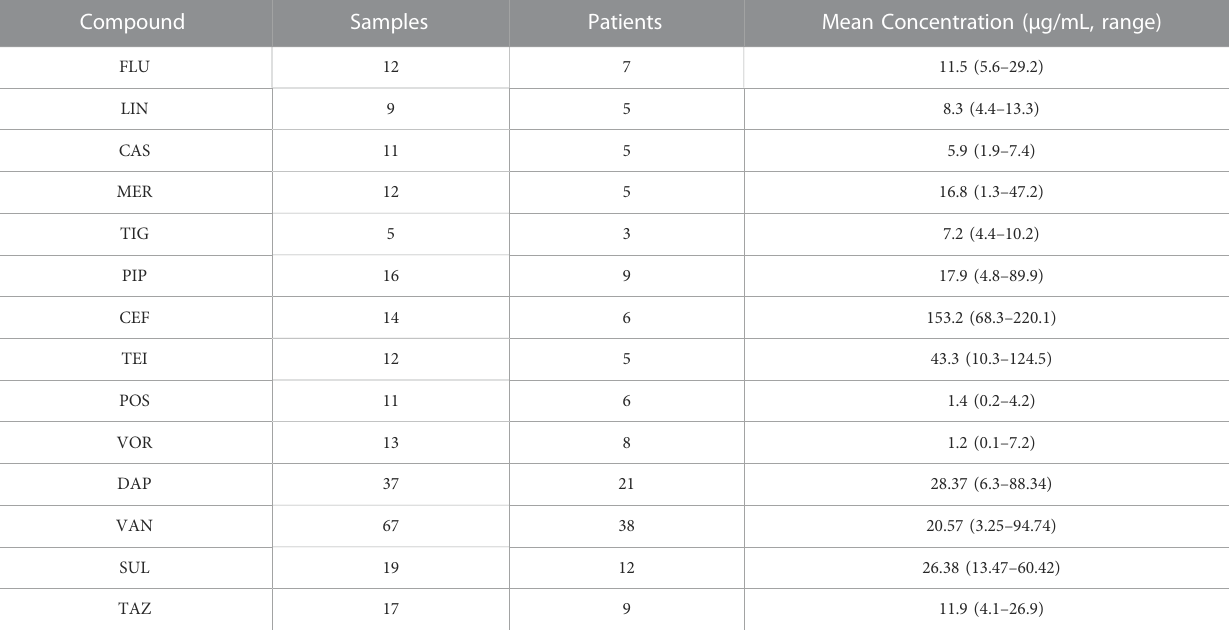
TABLE 4 Results of the measurement of antibacterial agents in samples collected from ICU patients.